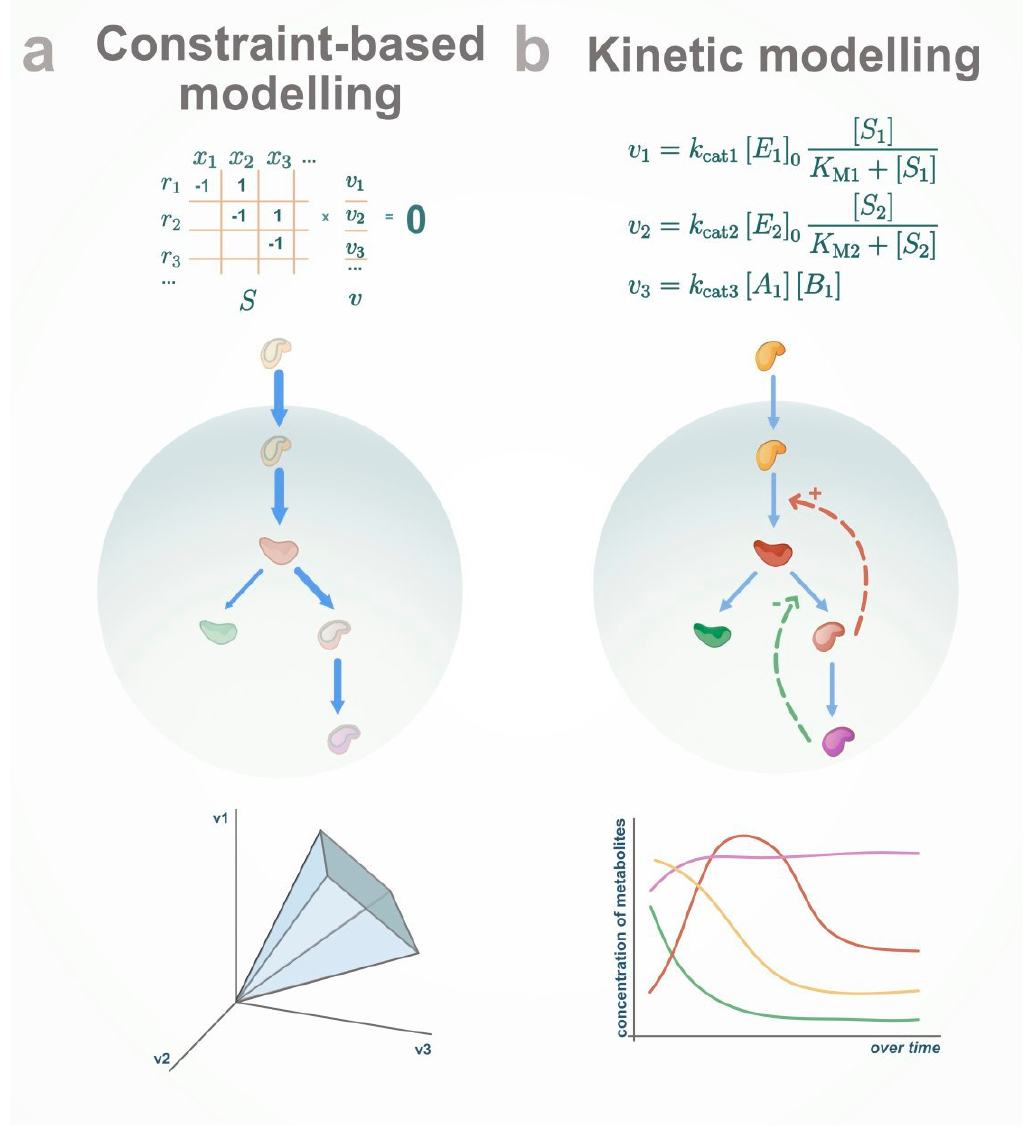
Figure 1. Modelling approaches to study metabolism. ( a ) Constraint-based modelling allows balancing the fluxes in the system, but cannot work with metabolite concentration directly. ( b ) Kinetic modelling allows the simulation and analysis of the dynamic behavior of metabolite concentration over time.